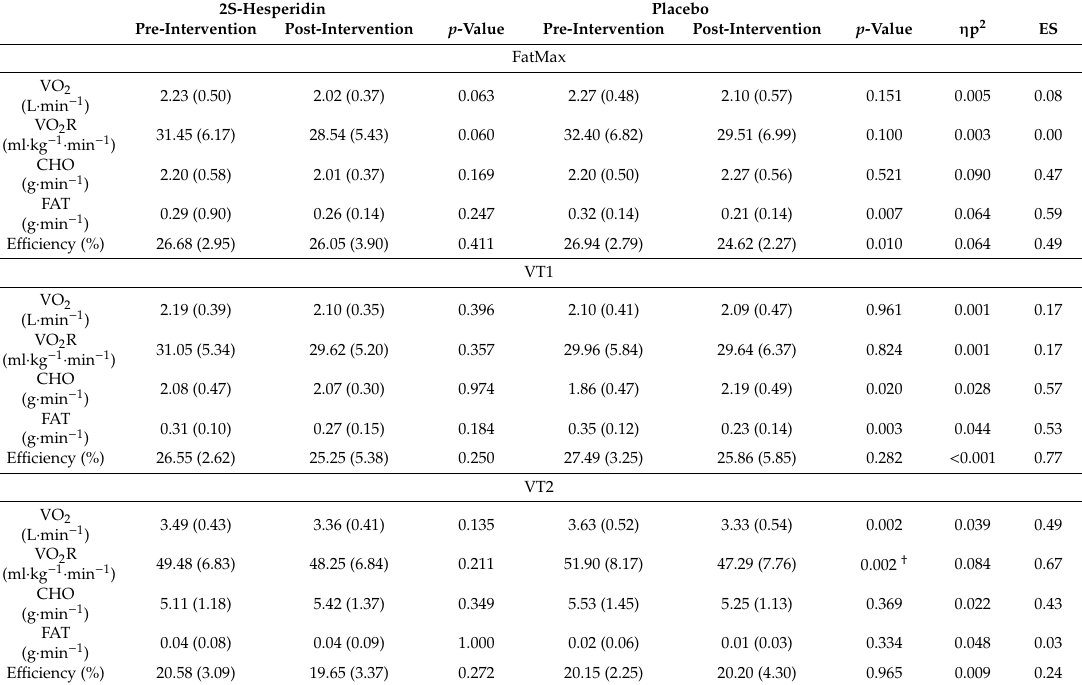
Table 3. Changes in metabolism, energy substrate, energy and energy e ffi ciency in FatMax, ventilatory threshold 1 (VT1) and ventilatory threshold 2 (VT2) during the step test. 2S-Hesperidin Placebo